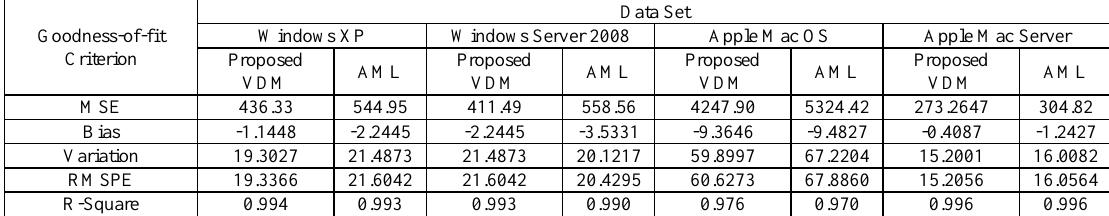
Table 2. Model comparison results